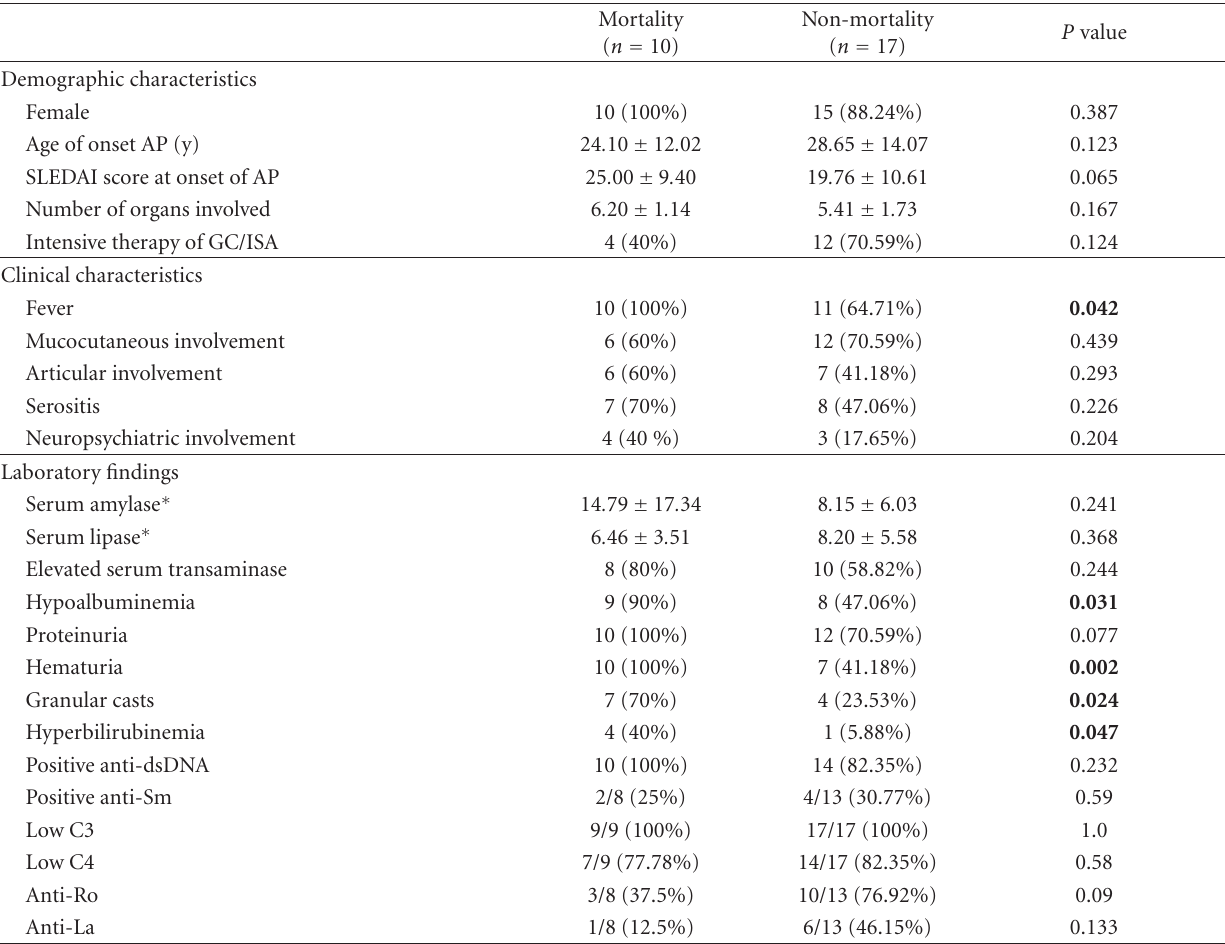
Table 4: Comparison of demographic and clinical characteristics between mortality and non-mortality group.